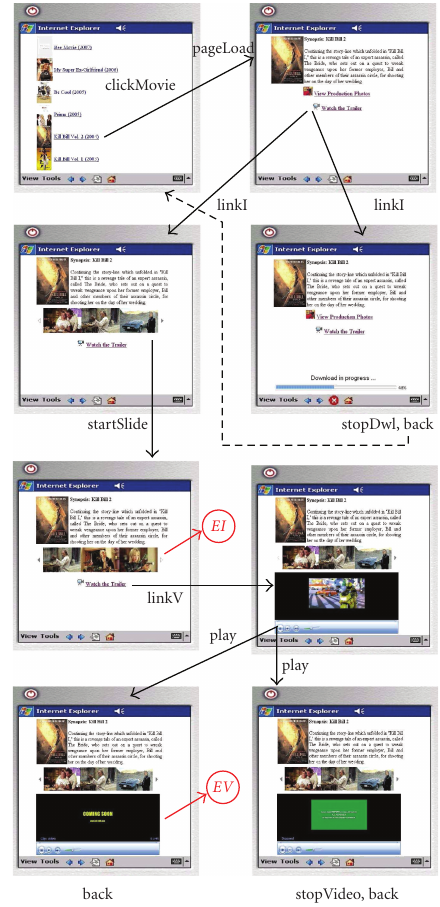
Figure 4: Example of navigations and interactions.